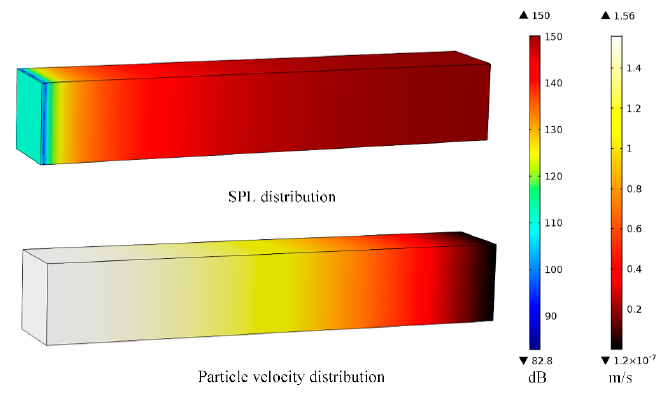
Figure 4. Sound-pressure level (SPL) distribution and particle-velocity distribution of a 0.6 m long quarter-wavelength tube resonator at 143 Hz.